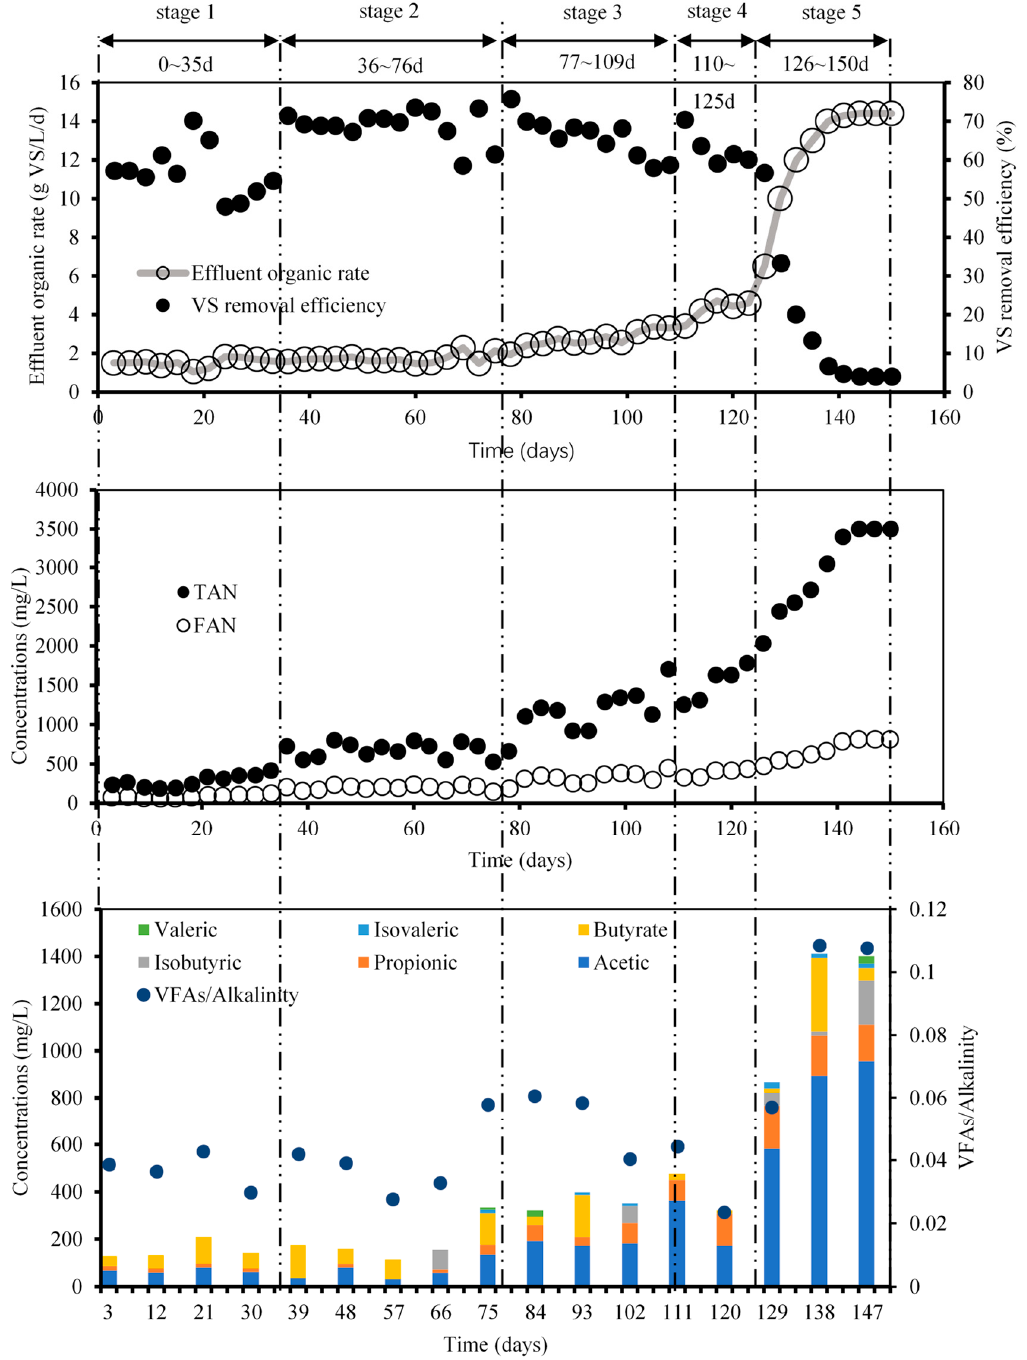
Figure 3. E ff ect of OLR on the VS removal e ffi ciency, e ffl uent organic rate, and the TAN, free ammonia Figure 3. Effect of OLR on the VS removal efficiency, effluent organic rate, and the TAN, free ammonia 235 nitrogen (FAN), and volatile fatty acid (VFA) nitrogen (FAN), and volatile fatty acid (VFA) concentrations. 236